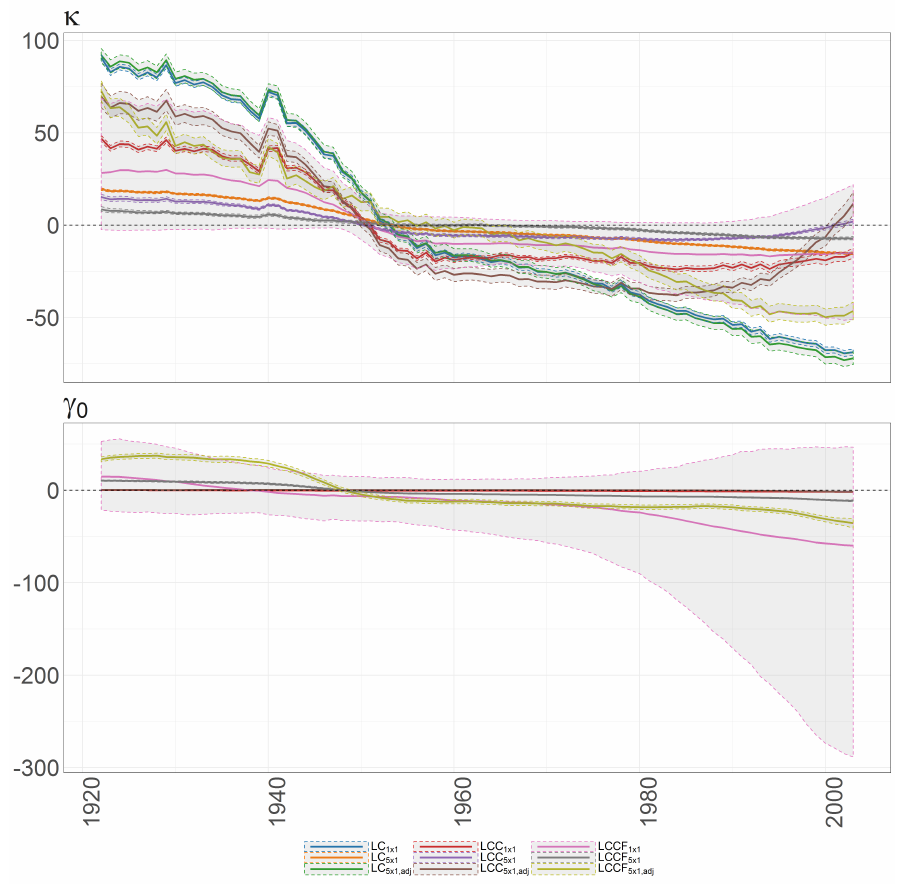
Figure 39. The Bayesian posterior mean estimates with 95% posterior credible intervals for κ t ( upper panel ) and cohort effect state process γ 0 ( lower panel ) under different models (colours of t lines) for British female log death rates during